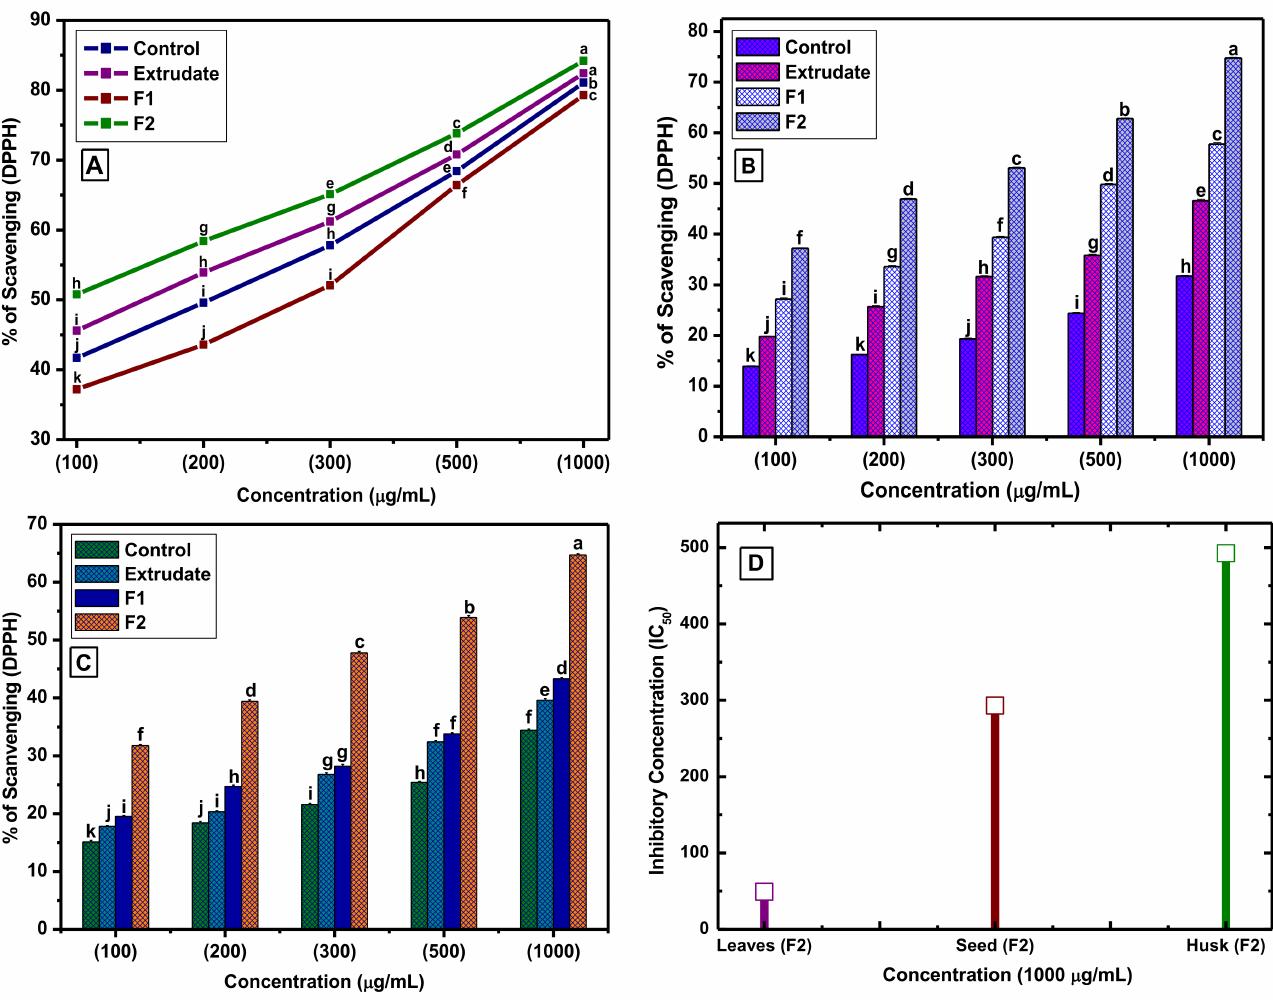
Figure 1. DPPH free radical scavenging capacity. ( A ) Moringa leaves composites (MLC), ( B ) moringa seed composites (MSC), ( C ) moringa husk composites (MHC), and ( D ) inhibitory concentration (IC 50 ) of F2. Mean ± SD from triplicate separated experiments are shown. Values expressed by different letters in each column are significantly different in the t -test ( p <